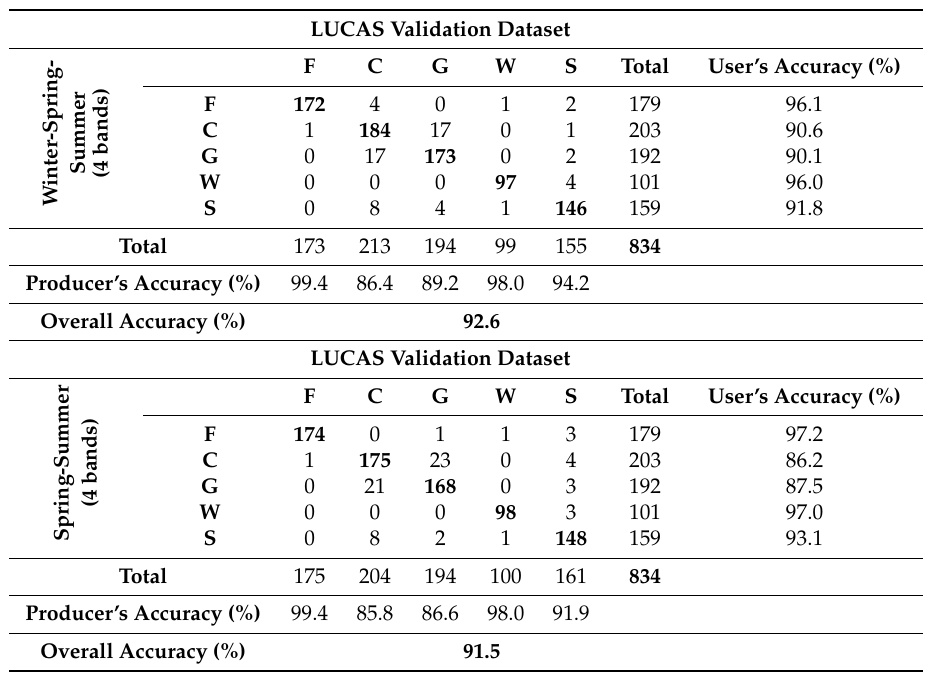
Table 5. The confusion matrixes for the multidate classification with 4 (B2, B3, B4, and B8) and 10 spectral bands (B2, B3, B4, B5, B6, B7, B8, B8a, B11, and B12). ( a ) Winter-spring-summer classification with 4 bands; ( b ) spring-summer classification with 4 bands; ( c ) winter-spring-summer classification with 10 bands; ( d ) spring-summer classification with 10 bands. The reference data used here were the LUCAS validation dataset with 834 points. The winter-spring-summer classification with 4 bands yielded the best OA with 92.6%. It was followed by the spring-summer classification with 4 bands (91.5%) and the spring-summer classification with 10 bands (90.2%). The winter-spring-summer classification with 10 bands yielded the worst OA